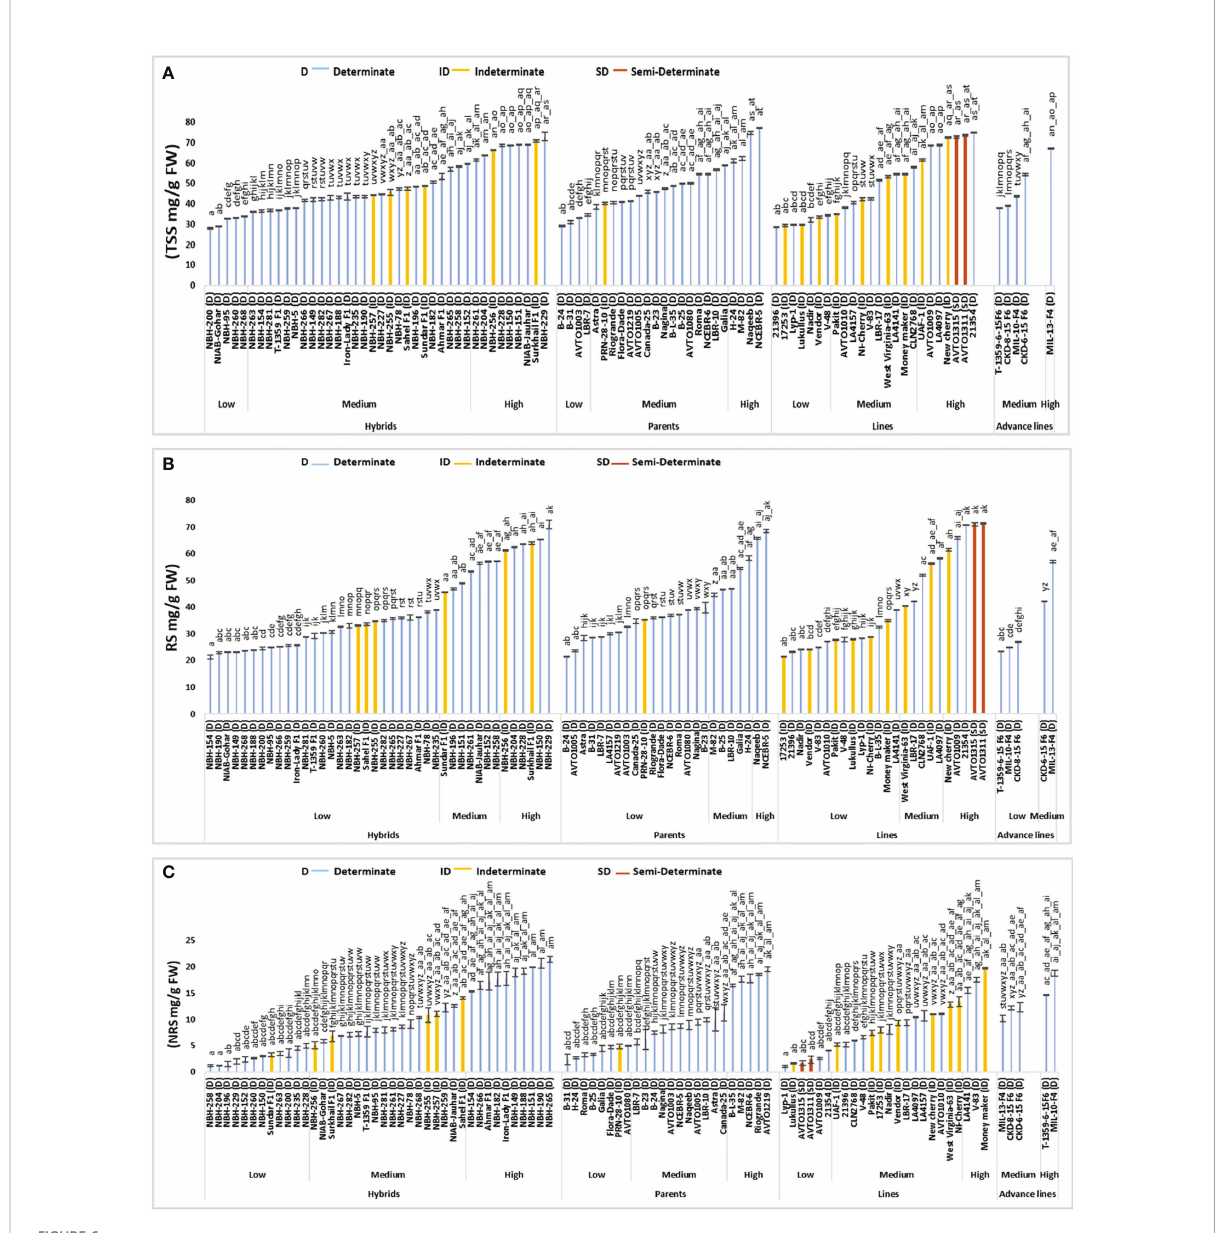
FIGURE 6 Comparison of fruit (A) total soluble sugars (TSS), (B) reducing sugars (RS) and (C) non-reducing sugars (NRS) in different tomato genotypes (mean value ± SD). Mean value with varying alphabet differs signi fi cantly (p < 0.05, Tukey ’ s